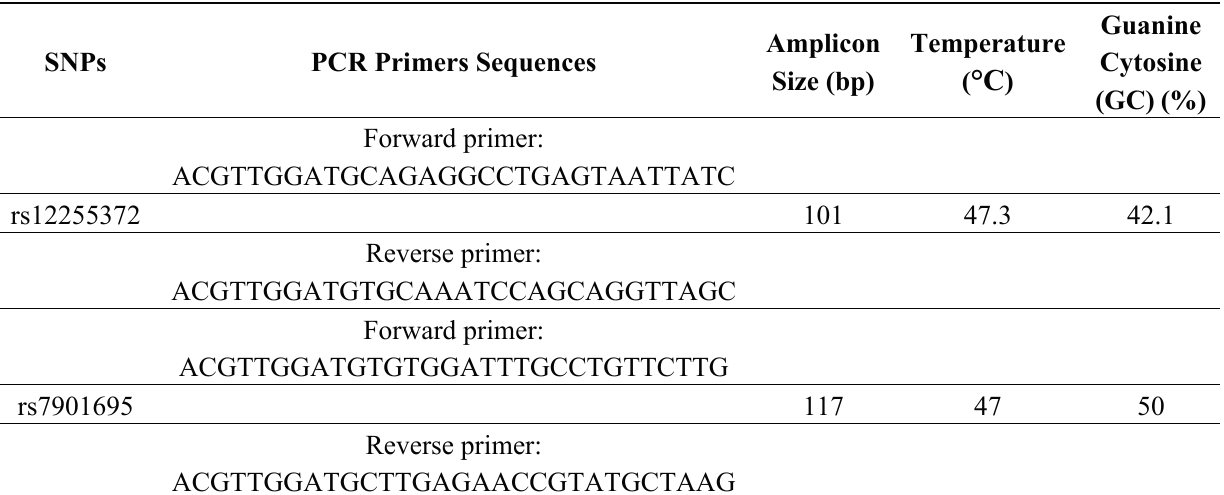
Table 1. Primer sequences of each